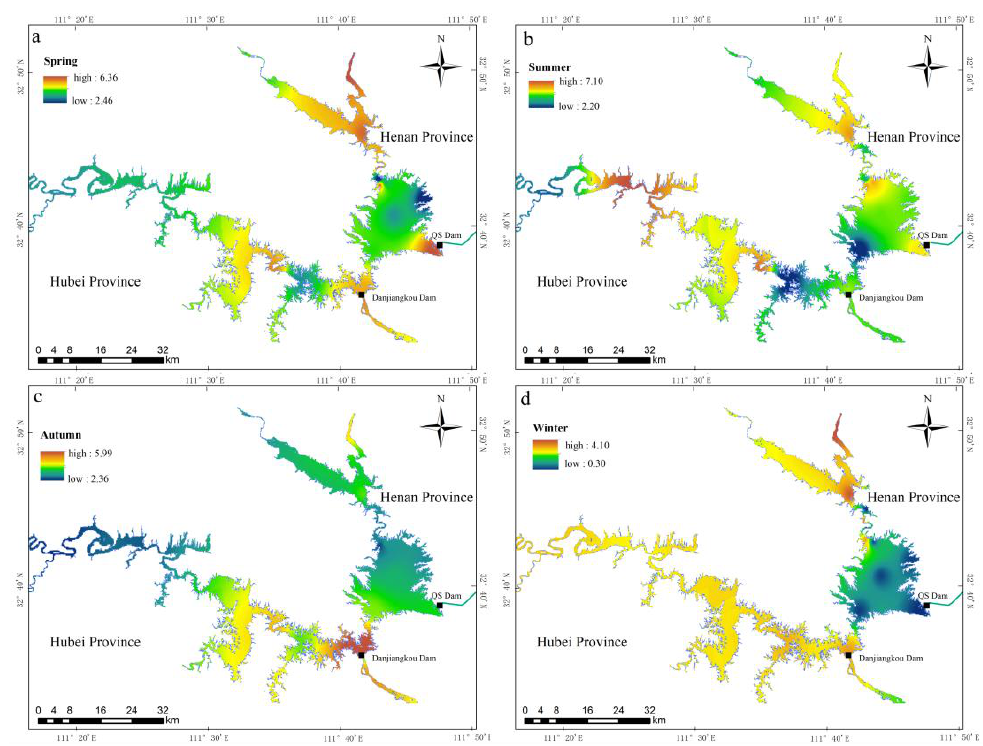
Figure 2. Spatio-temporal distribution of TOC concentration in the Danjiangkou Reservoir: ( a ) spring, ( b ) summer, ( c ) autumn, and ( d ) winter.